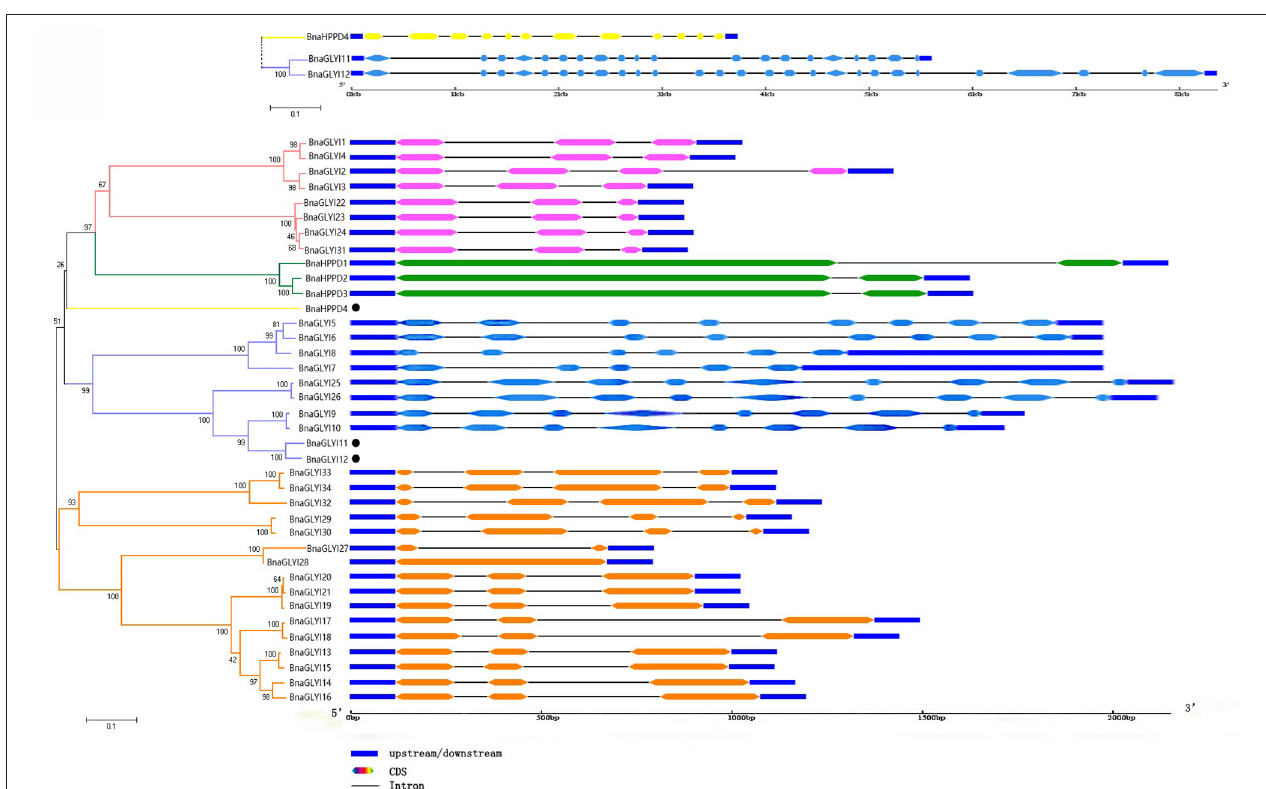
FIGURE 5 | Exon-intron organization of the BnaVOC genes. Double-sided wedge boxes represent exons, and different colors indicate sub-clade families. Black lines represent introns, and untranslated regions (UTRs) are indicated by mazarine boxes. The lengths of the proteins and motifs can be estimated using the scale at the